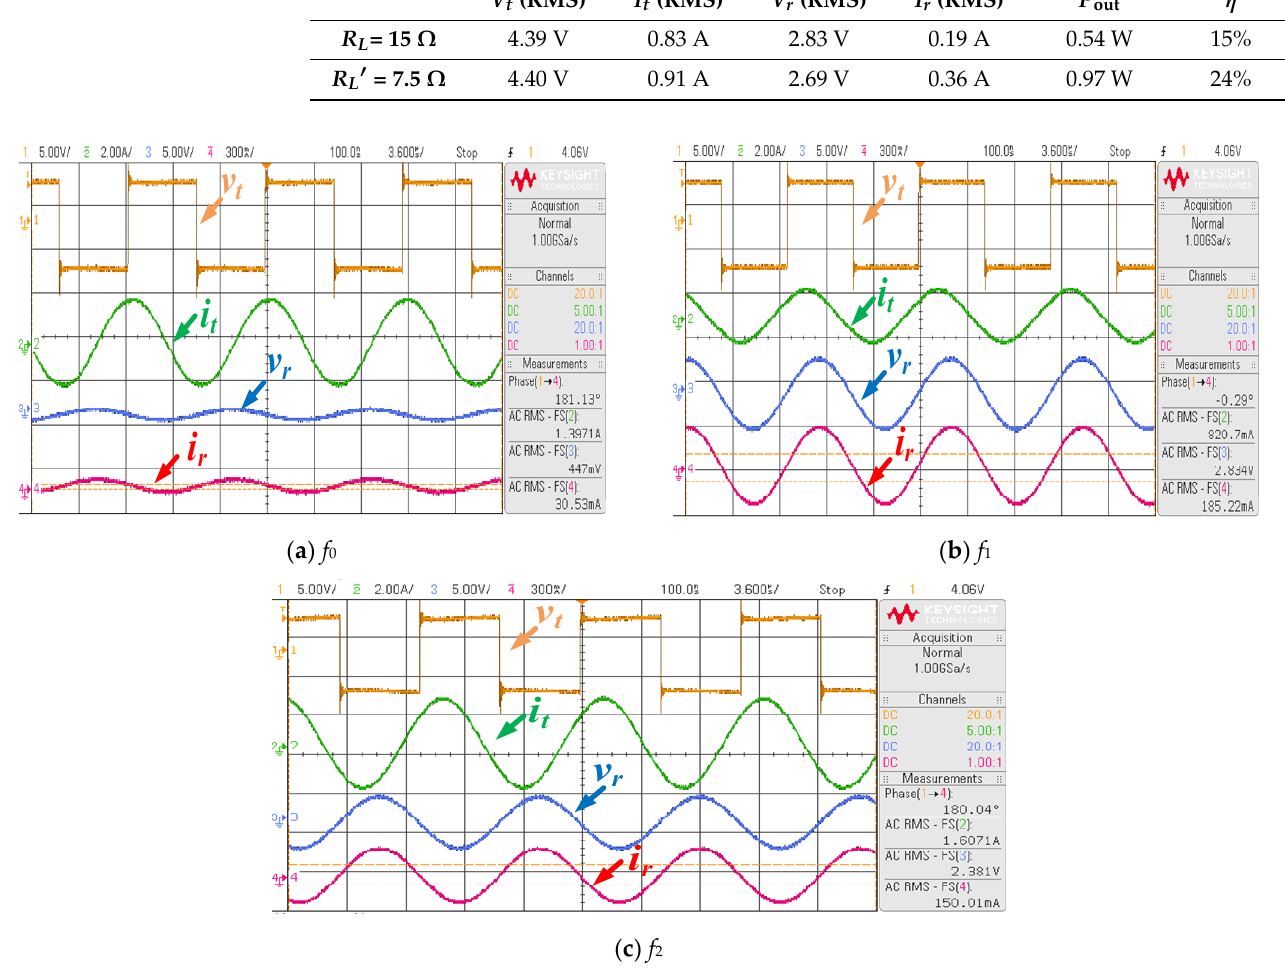
Figure 9. Experimental waveforms of v t , i t , v r , and i r at f 0 , f 1 , and f 2 , respectively.